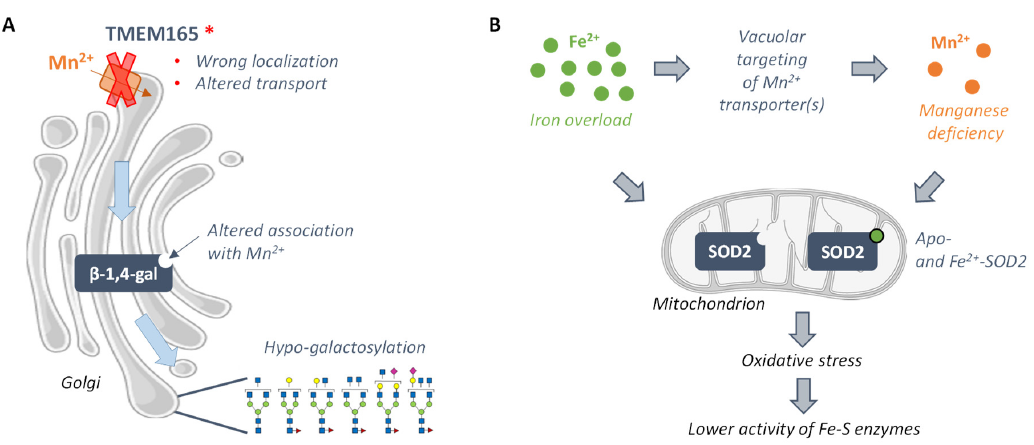
Figure 2. Manganese-related molecular mechanisms beyond the development of Transmembrane protein 165-Congenital Disorder of Glycosylation (TMEM165-CDG) ( A ) and of Friedreich ataxia ( B ). ( A ) Disease-causing mutations within the human gene coding for the Golgi-localized protein TMEM165 are thought to cause its mislocalization or to a ff ect its transport capacity, both leading to disturbed manganese homeostasis in the Golgi lumen. In this compartment, the altered bioavailability of manganese for the Mn 2 + -dependent β -1,4-galactosyltransferase ( β -1,4-gal) would a ff ect its enzymatic function and lead to the production of hypo-galactosylated N-glycans. ( B ) Friedreich ataxia is characterized by a decreased production of the mitochondrial frataxin and by iron overload. This metal overaccumulation is, in turn, thought to induce, in yeast, vacuolar targeting of the protein Smf2p, that plays a key role in manganese dispatching within the cell, which, in turn, leads to cellular manganese deficiency. Both manganese deficiency and iron overload drive the formation of the inactive apo- and Fe-bound superoxide dismutase 2 (SOD2), thereby altering oxidative stress protection and leading to decreased activities of the Fe-S